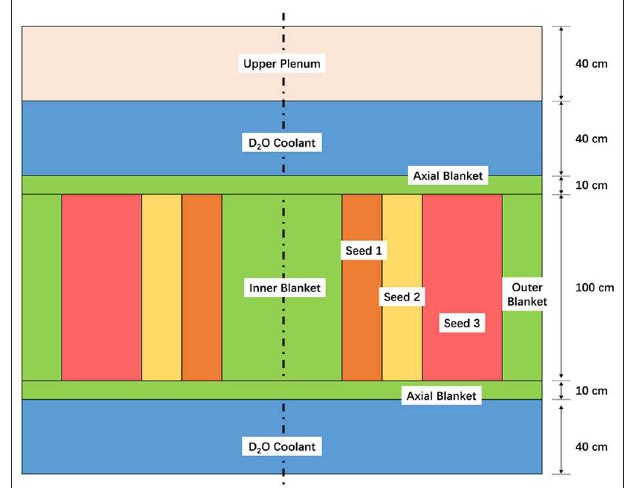
FIGURE 3 | Axial schematic view of RMSMR-Th.